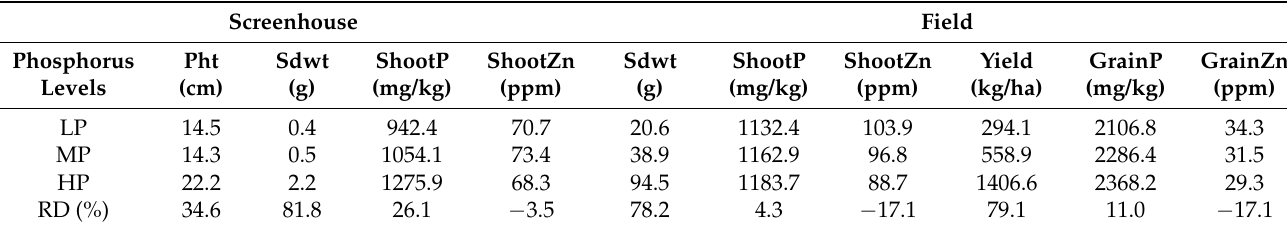
Table 2. Relative difference (RD) in performance of high phosphorus treatment relative to low phosphorus on some traits measured in the screenhouse and field conditions.